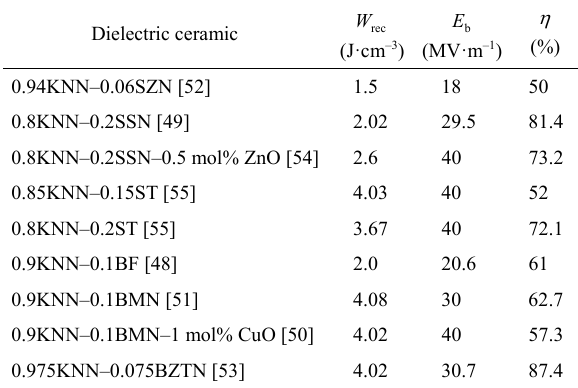
Energy-storage properties of KNN-based bulk ceramics Dielectric ceramic rec